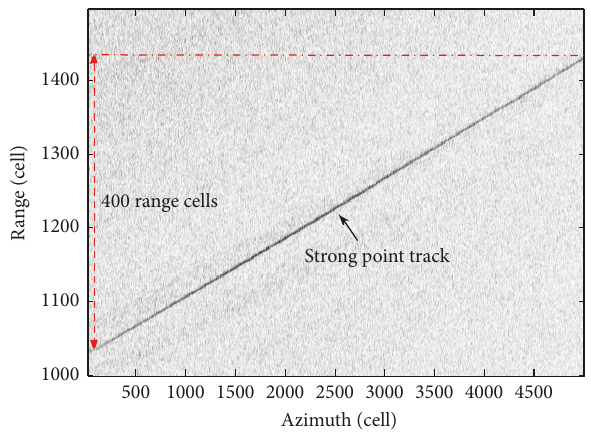
Figure 12: Imaging result based on conventional RCMC (bistatic radar). The defocusing of the image is much more serious than that in the monostatic SAR due to the larger RCM.